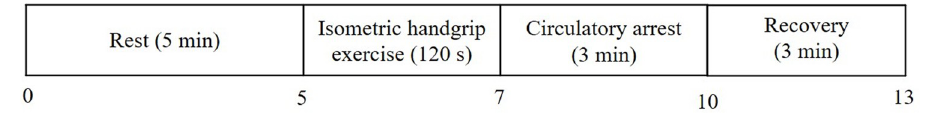
Fig 4. Post-exercise circulatory arrest (PECA) protocol used during muscle metaboreflex activity